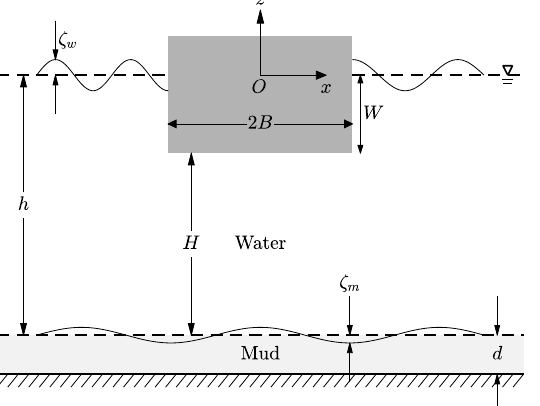
Figure 1. An immiscible two-layer system for wave scattering by a surface rectangular obsta- cle above a a muddy seabed. h , H = water depths, d = mud layer thickness, 2 B = obstacle length, W = obstacle submerged depth, ζ w = free-surface displacement, ζ m = water–mud inter- facial displacement, ( x , z ) = horizontal and vertical coordinates. The fluid mud layer is on top of a solid